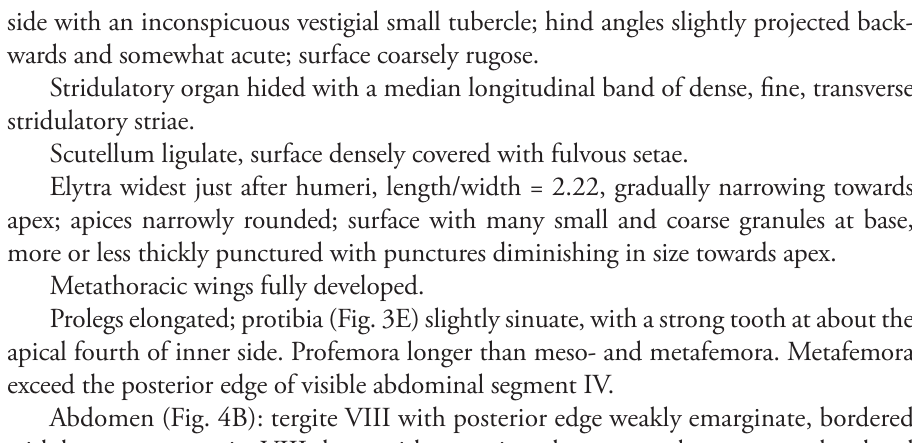
Figure 3. Pseudomacrochenus wusuae sp. n. (paratype). A head ( ♂ ; front view) B head ( ♀ ; front view) C pronotum ( ♂ ; dorsal view) D pronotum ( ♀ ; dorsal view) E protibia ( ♂ ; dorsal view) F protibia ( ♀ ; dorsal